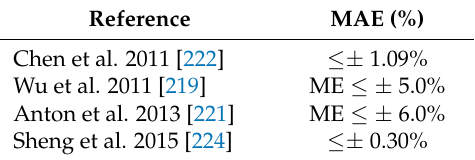
Table 21. MAE/ME of the SVM-based SOC estimation